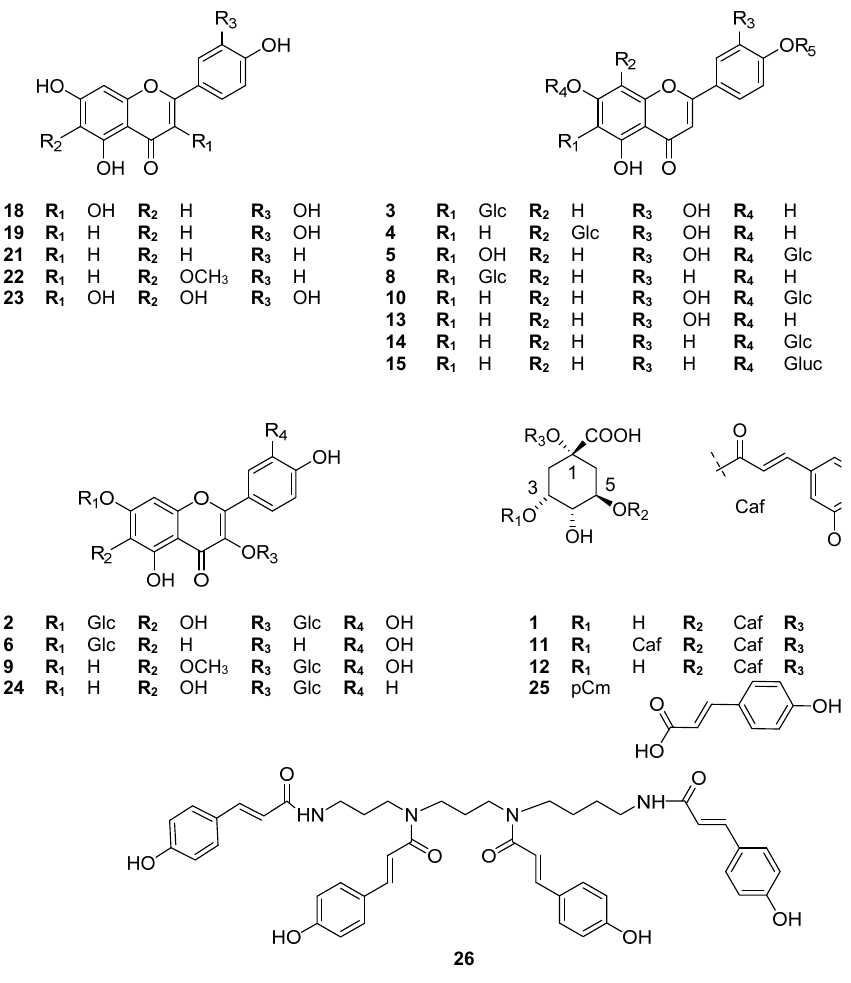
Figure 1. Constituents isolated and/or detected in Matricaria pubescens flowers. Glc: glucose; Gluc: glucuronic acid; Caf: caffeic acid.